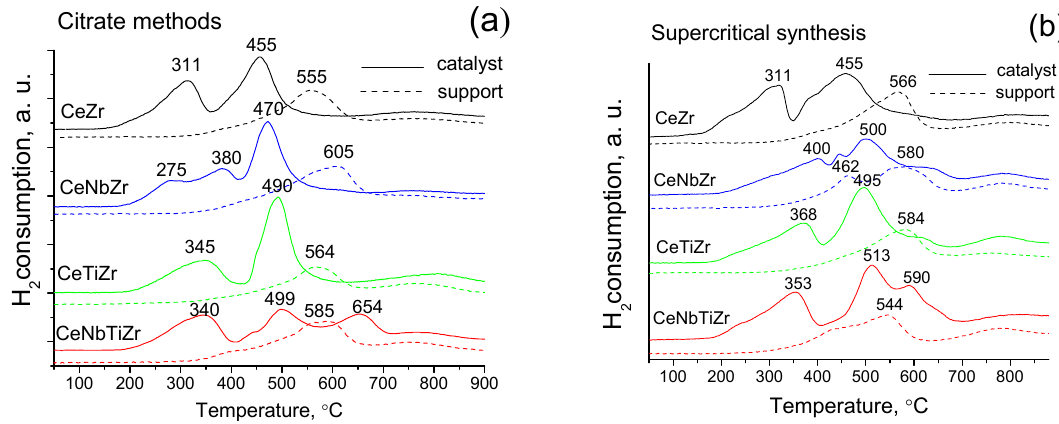
Figure 11. H 2 - TPR spectra of supports and Ni-catalysts prepared by ( a ) citrate methods and ( b ) by supercritical synthesis and sintered at 700 ◦